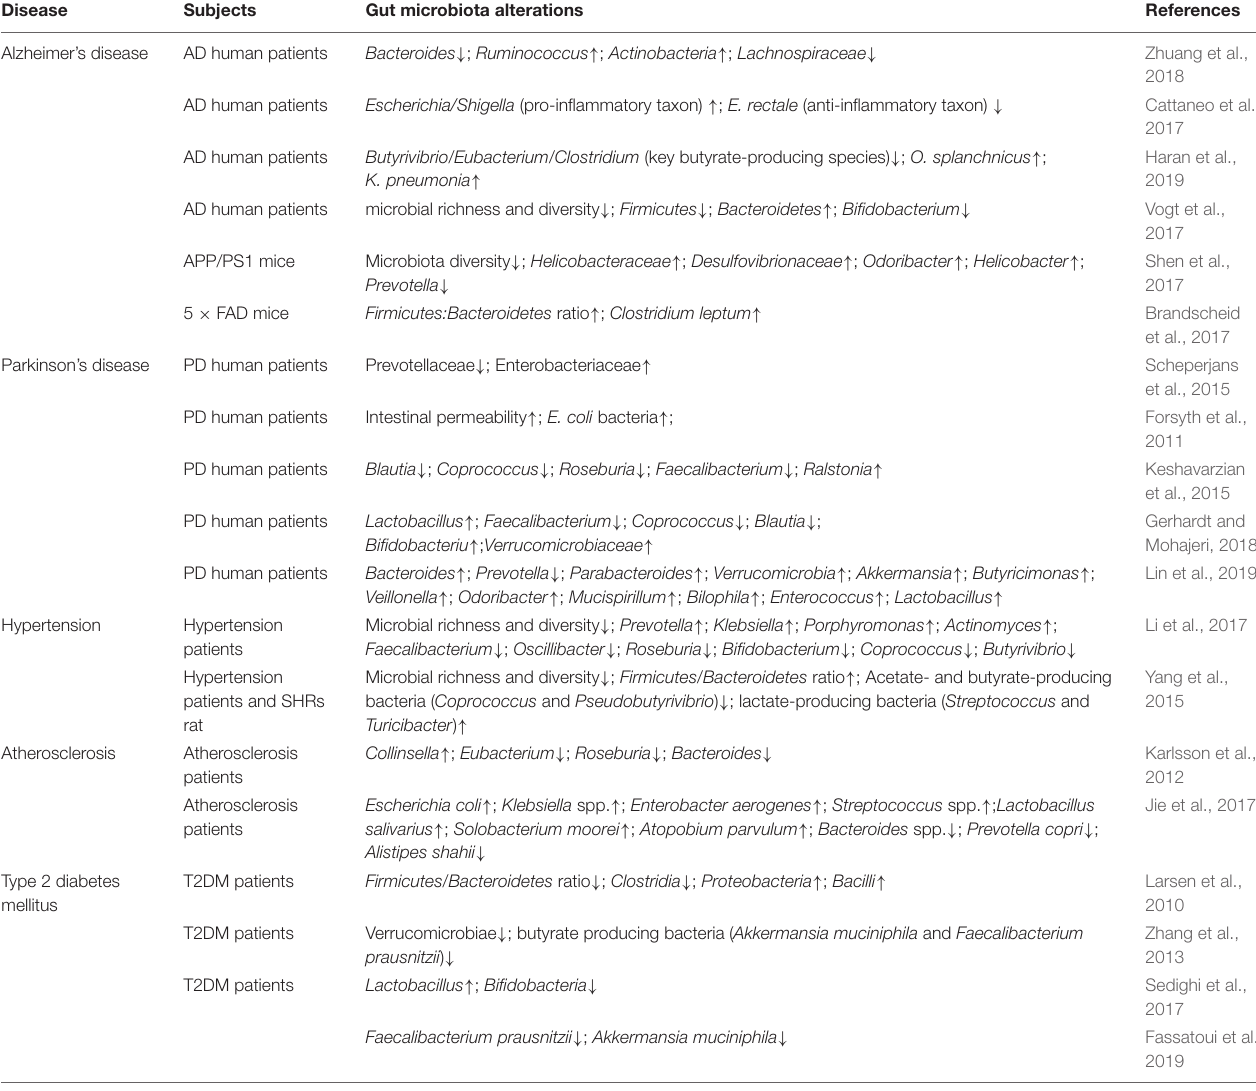
TABLE 1 | Alterations of the gut microbiota in different geriatric